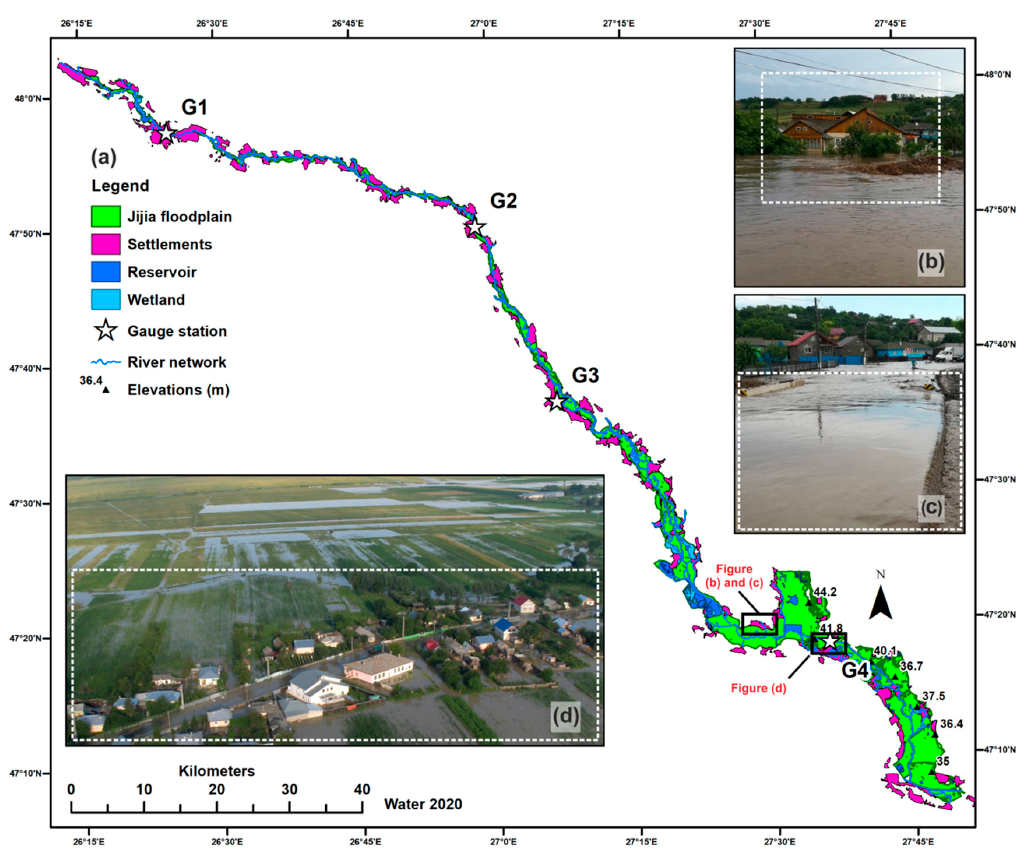
Figure 2. ( a ) Habitation characteristics in the Jijia floodplain vs. flood hazards: ( b ) houses and ( c ) roads affected by a flash flood that occurred in Mihail Kogalniceanu settlement (lower sector of the Jijia floodplain) on 15 April 2018; ( d ) traces of a flood event that occurred in the summer of 2008 and affected the rural settlements from the common floodplain of the Jijia-Prut rivers.